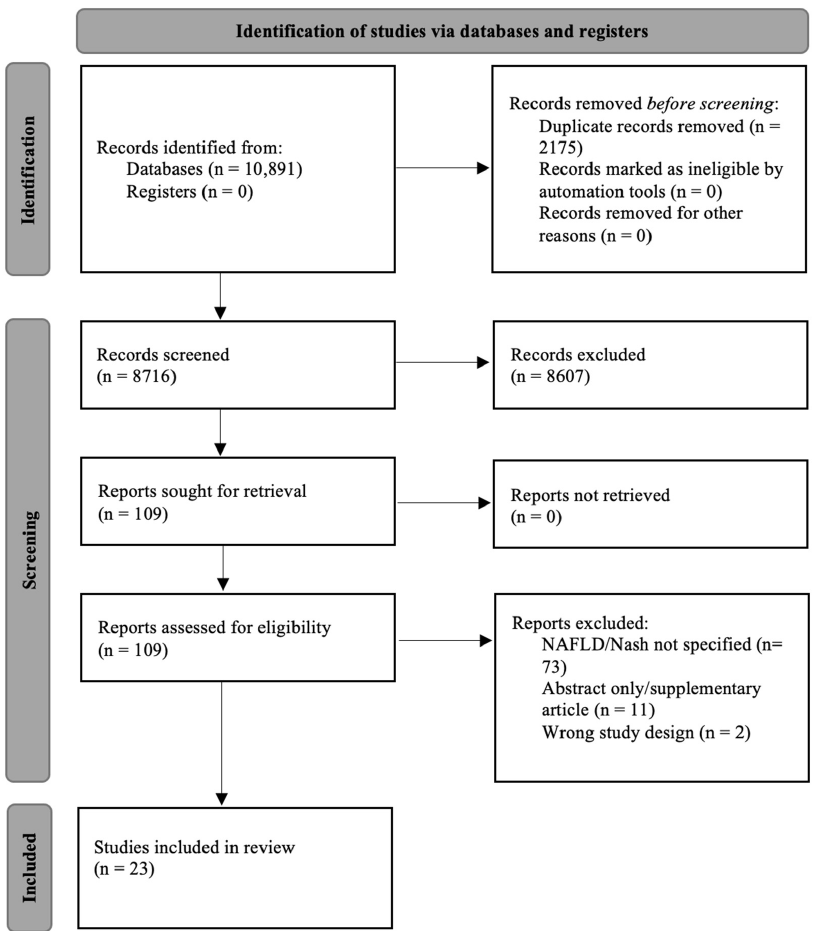
Figure 1. Preferred reporting items for systematic review and meta-analysis (PRISMA) statement flow diagram.